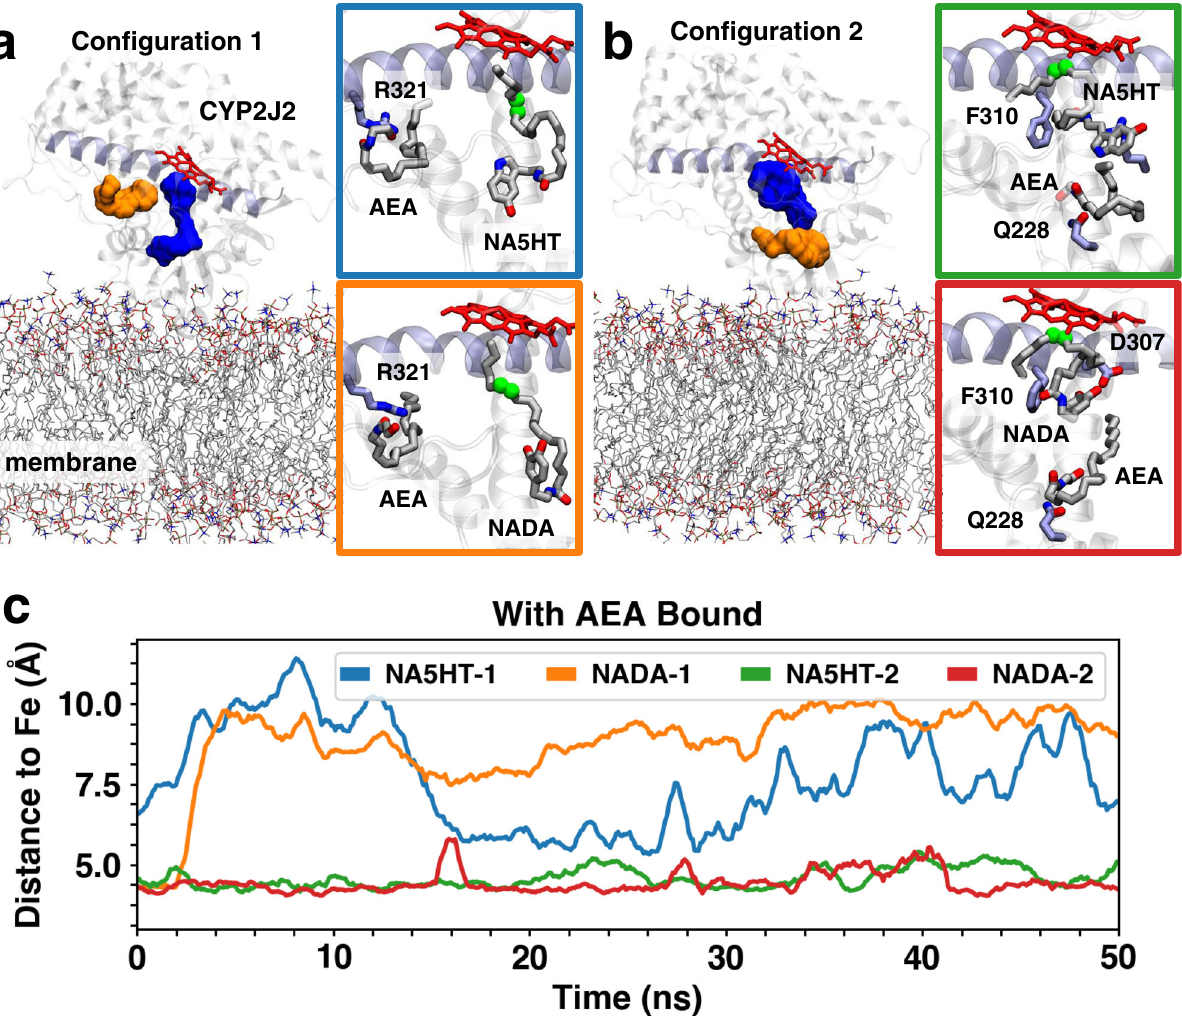
Fig. 4 Concurrent CYP2J2 binding of AEA and NADA/NA5HT in MD simulations. Representative snapshots of two distinct con fi gurations of AEA and NADA/NA5HT identi fi ed with molecular docking and with MD simulations: a peripheral binding pocket located near helix I (shown in purple cartoon) and b peripheral binding site near the membrane interface. In both panels, peripheral and active binding site cavity are shown as orange and blue surfaces, respectively. Lipids are shown in stick representation and CYP2J2 in cartoon representation. AEA, NADA, and NA5HT molecules are shown as sticks. Notable residues involved in AEA/NADA/NA5HT interactions are also shown as sticks. Carbons involved in epoxidation are highlighted as green spheres. c Time series of carbon-to-heme distances obtained from 50 ns MD simulations for the main epoxidation sites of NADA/NA5HT. Colors correspond to the subpanels shown in a and b